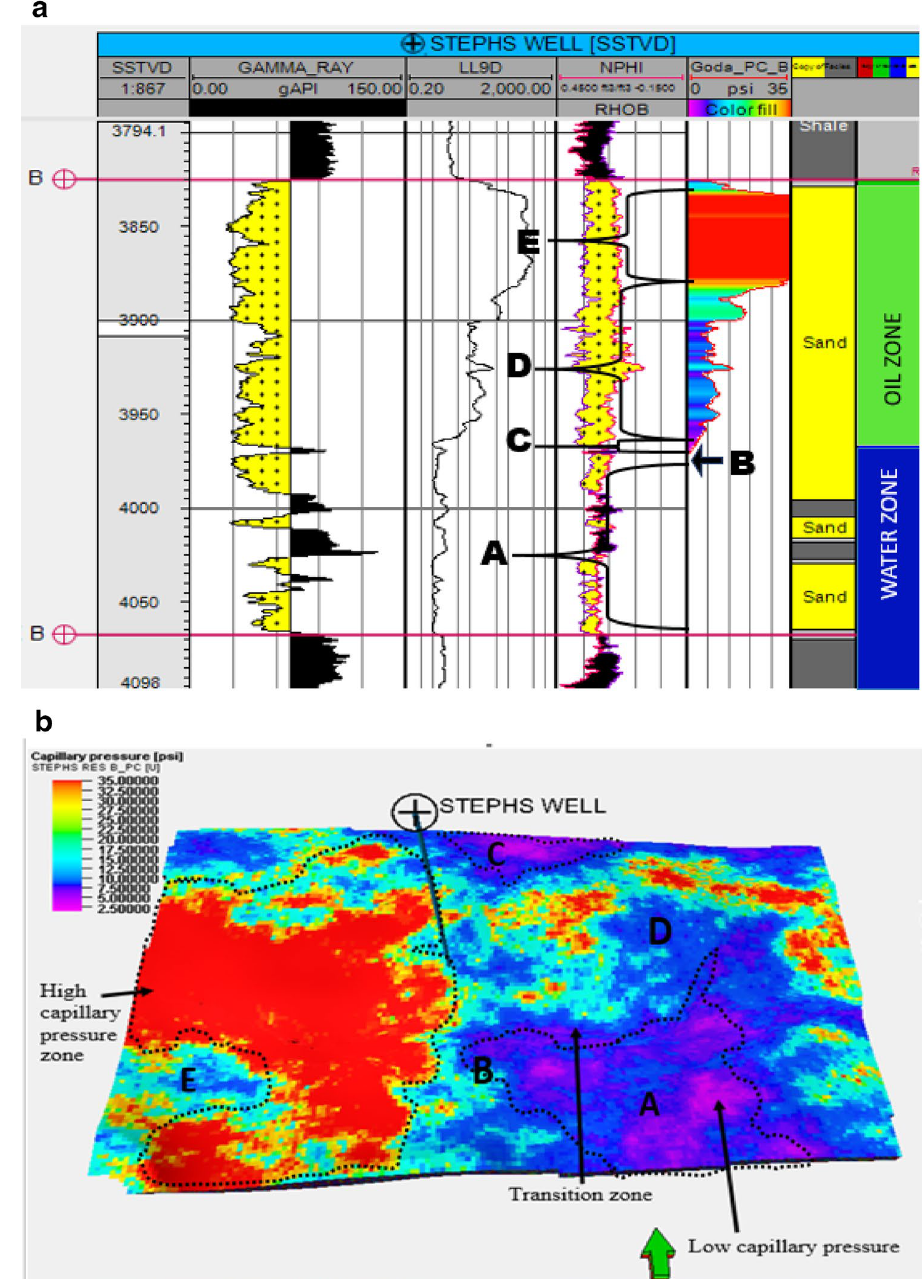
Fig. 12 a Well section with cap- illary pressure log for reservoir B. A is FWL, B is OWC, C is entry pressure, D is transition zone and E is the zone fully saturated with hydrocarbon. b Capillary pressure model for reservoir B (A is FWL, B is OWC, C is low-P c zone, D is transition zone and E is the zone fully saturated with hydrocar-